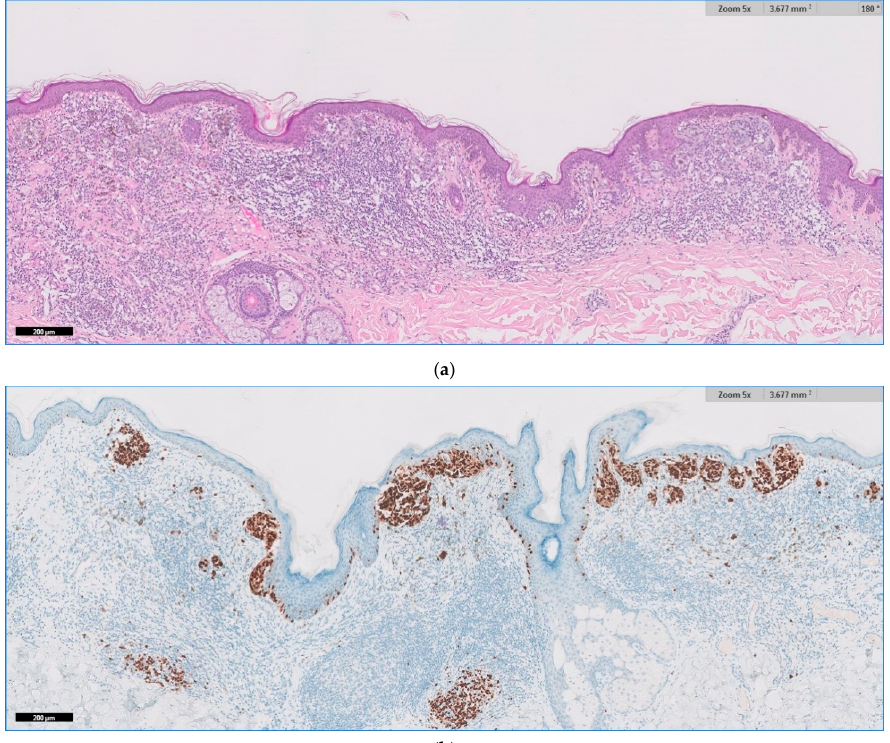
Figure 5 . ( a ) HE and ( b ) SOX10. Melanocytic lesion with irregular distribution of nests at the dermal–epidermal junction and dense chronic inflammation (halo type) within the dermis, partially obscuring the dermal component.